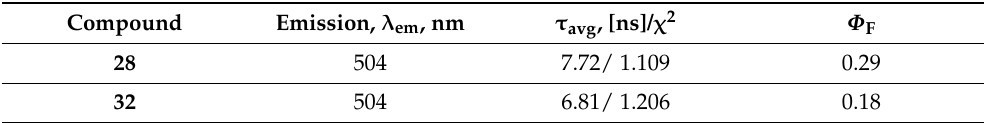
Table 6. Photoluminescent data for compounds 28 and 32 in powder at r.t.